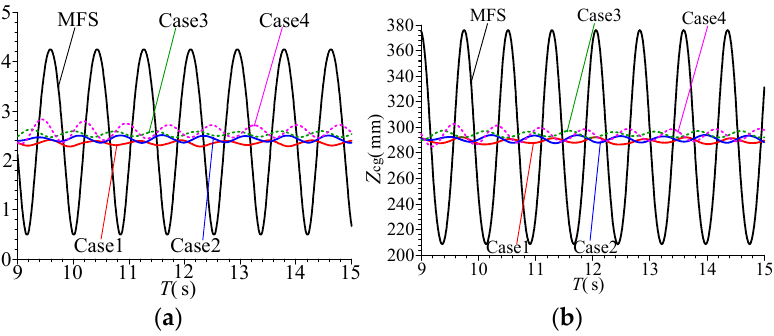
Figure 33. Oscillation comparisons of ( a ) τ and ( b ) Z cg when porpoising under condition 2. Table 12. The comparisons of the dimensionless oscillation amplitude of trim angle (C τ ), dimensionless oscillation amplitudes of sinkage ( C Z ), total average resistance ( R av ), maximum resistance ( R am ), and percentage of resistance increment ( PRI ) under condition two.